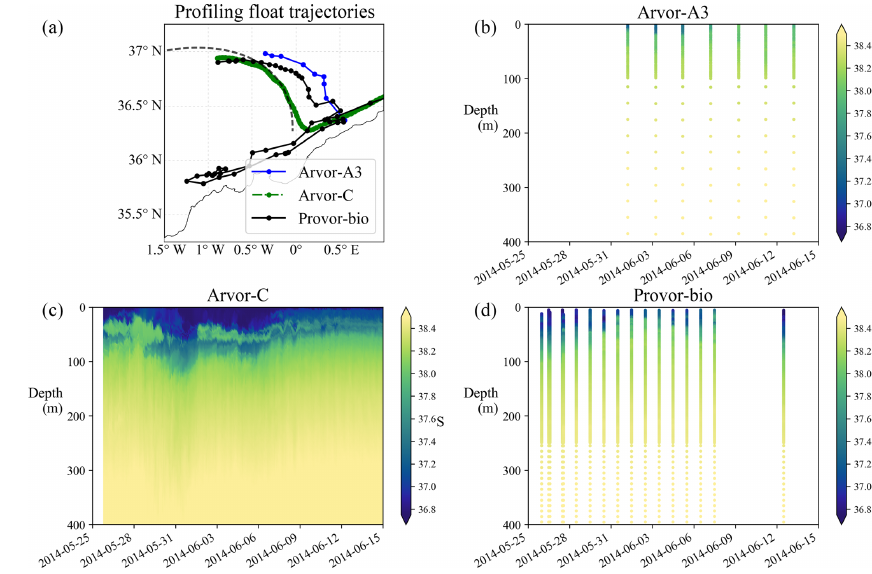
Figure 10. Profiling float trajectories and salinity from 25 May to 15 June